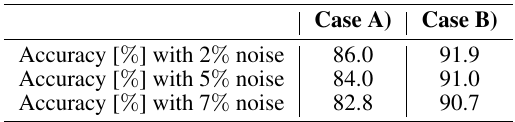
Table 3. Classification results using the labeled noisy images, varying the level of noise.